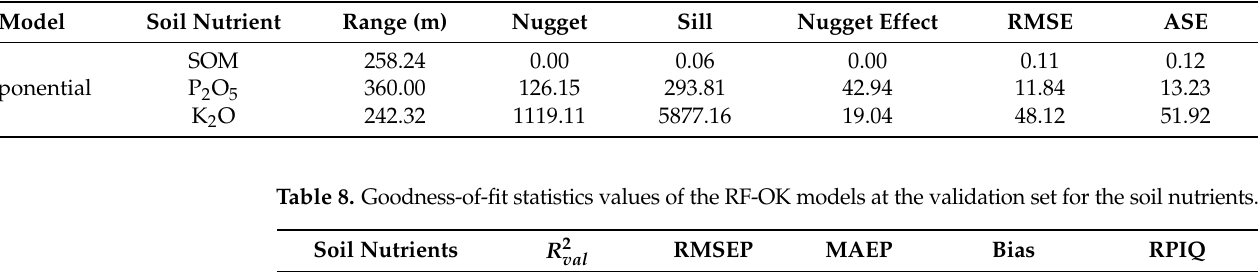
Table 8. Goodness-of-fit statistics values of the RF-OK models at the validation set for the soil nu- trients.